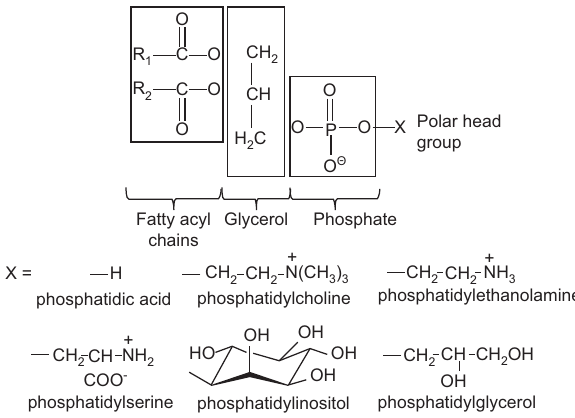
Figure 1 The general scheme of PL